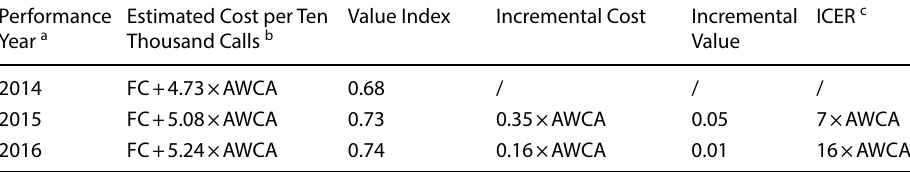
a 2013 data is excluded since it is not on the Efficiency